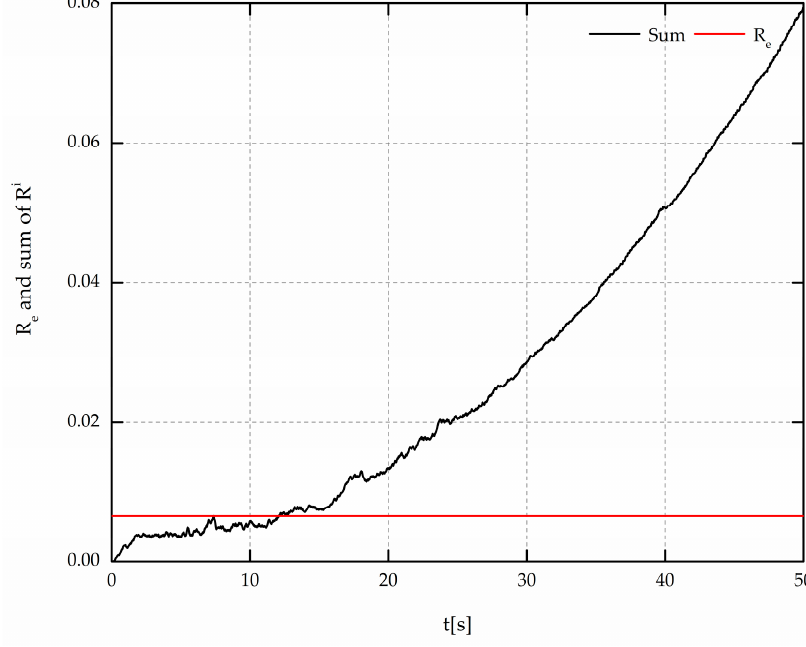
Figure 9. Comparison between threshold and sum of indicators in Mode 2.